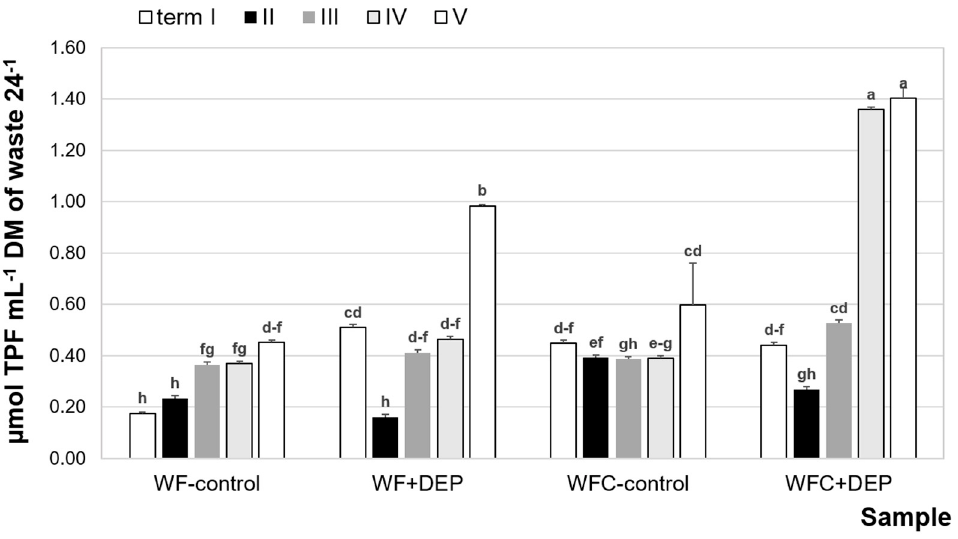
Figure 7. Dehydrogenase activity changes in the digested material. Explanation: the same letter indicates a lack of significant differences ( p < 0.05).